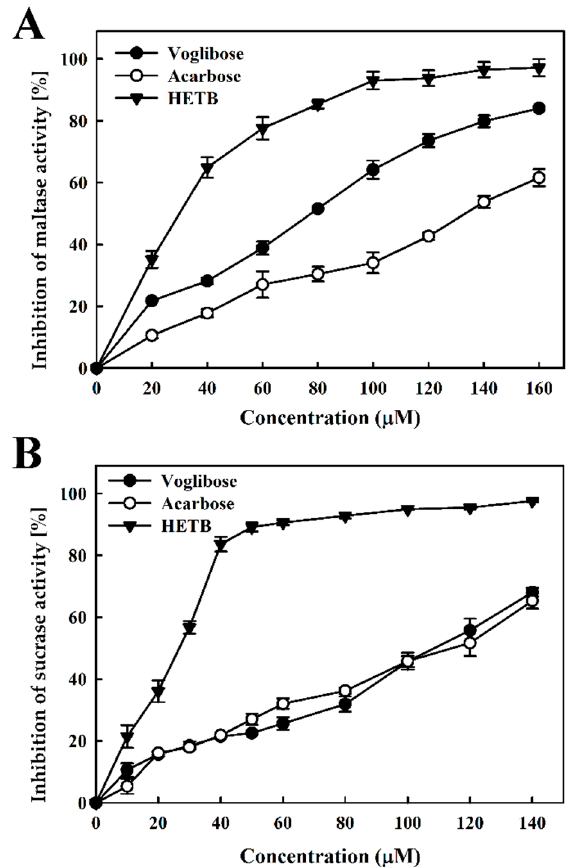
Figure 3. Inhibition of maltase ( A ) and sucrase ( B ) by acarbose, voglibose, and HETB at different concentrations. Data are presented as means of three independent determinations ± SD.